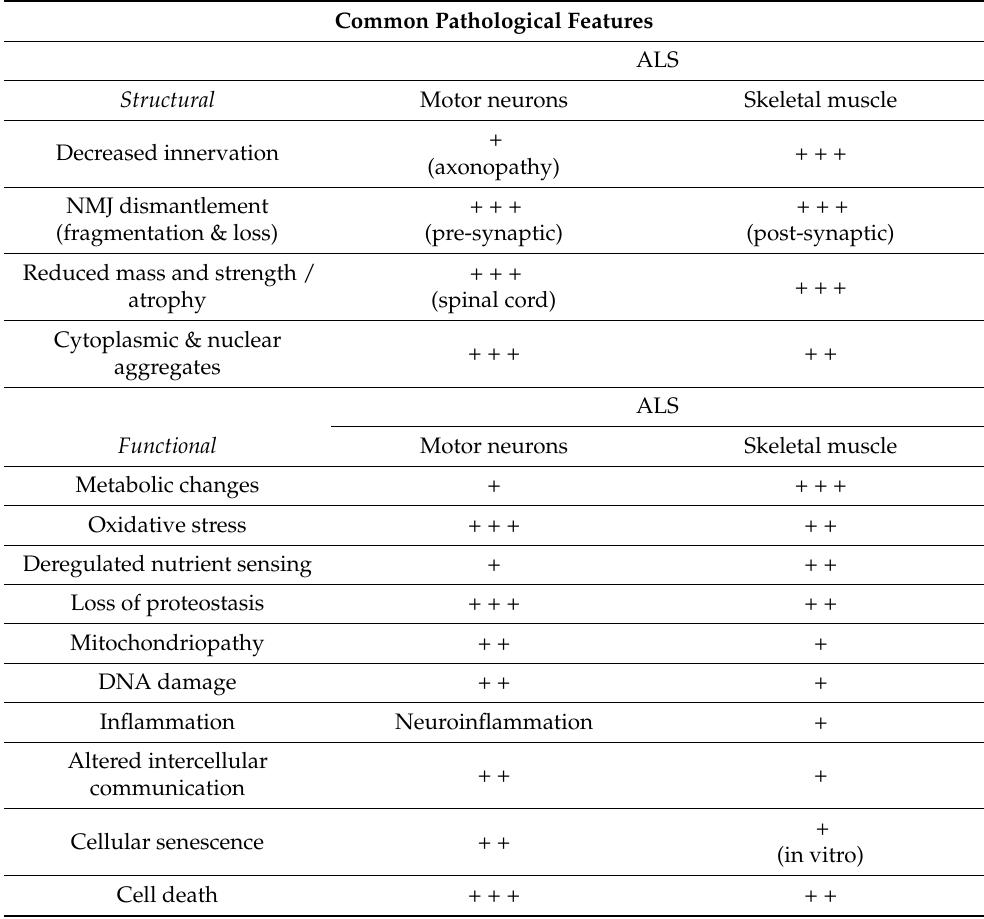
Table 1. Common pathological features in motor neurons and the skeletal muscle in ALS. Common Pathological